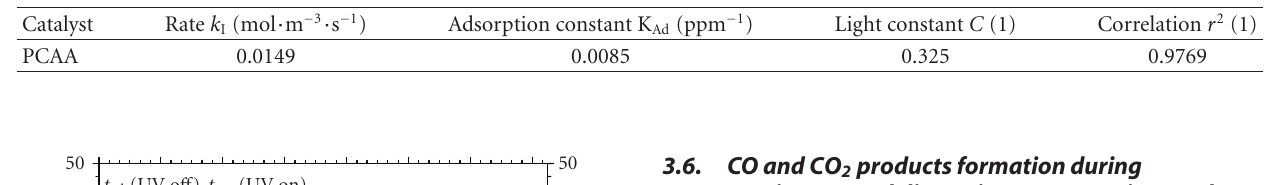
Table 2: Calculated kinetic parameters for the photocatalytic oxidation of TCE (25–300 ppm) on PCAA in dependence of UV-A light intensity (0–5.35 mW/cm 2 , 11mm fill thickness).